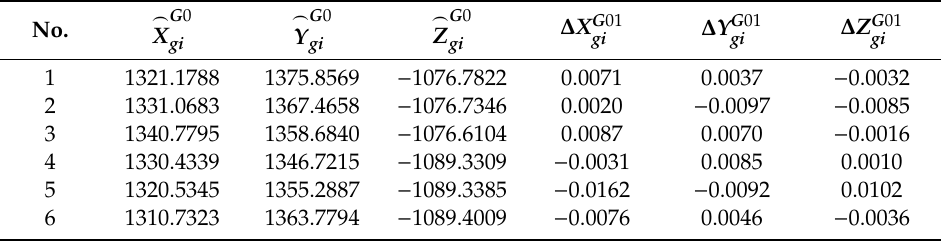
Table 3. Optimization data and correction data of common points of the laser tracker (unit: mm).